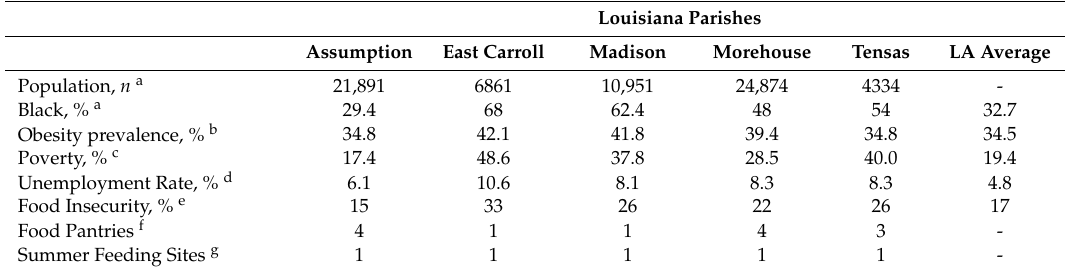
Table 1. Descriptive Characteristics of the Target